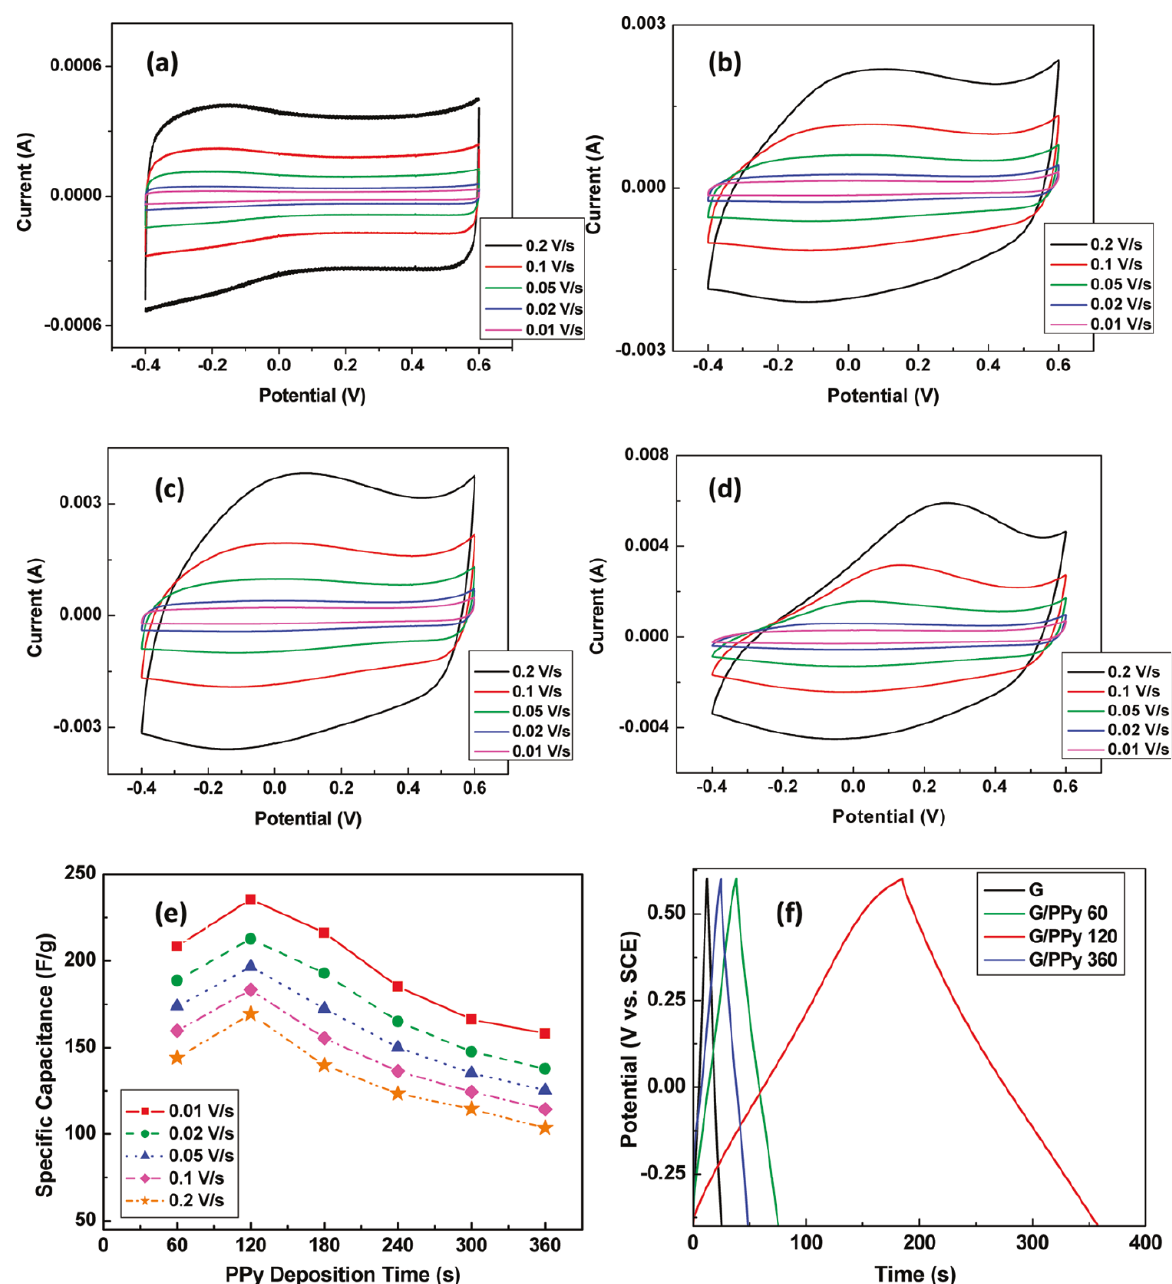
Figure 11. Cyclic voltammograms for ( a ) graphene, ( b ) graphene/PPy (60 s electrodeposition), ( c ) G/PPy (120 s electrodeposition), and ( d ) G/PPy (360 s electrodeposition) at different scan rates. ( e ) Specific capacitance of all G/PPy electrodes by electrodeposition time. ( f ) Galvanostatic charge–discharge curves for the electrodes in ( a – d ). Reproduced form ref. [55], copyright 2011, American Chemical Society.